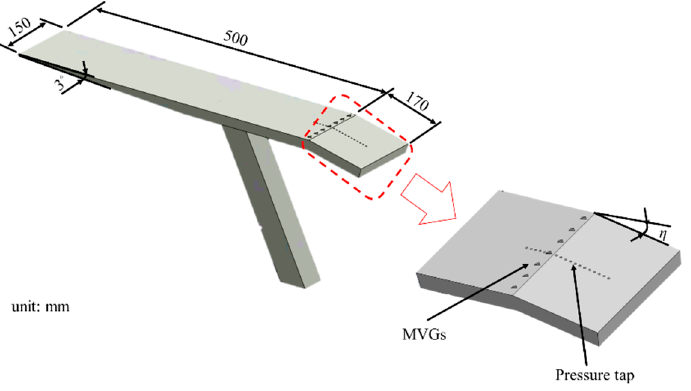
Figure 4. Test configuration.